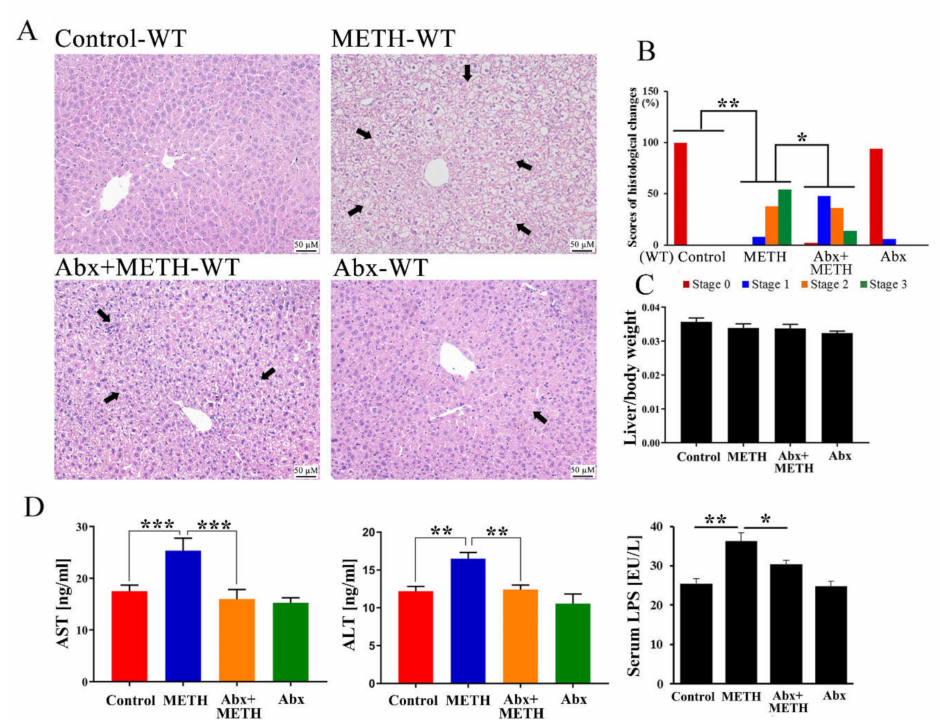
Figure 1. Histopathological changes, relative liver weight, and serum levels of AST, ALT and LPS. ( A ) H&E staining revealed shrinkage of the nuclei, loose cytoplasm and extensive vacuolar degeneration of hepatocytes (arrows) following METH treatment. However, pretreatment with antibiotics alleviated these histopathological changes. Bar = 50 µ M. ( B ) The scores of histological changes. ( C ) The relative liver weight following METH treatment. There was no significant change among groups. ( D ) The effect of METH treatment on serum AST, ALT, and LPS levels. METH treatment increased the serum AST, ALT, and LPS levels. However, treatment with antibiotics reversed this phenomenon. Abx, antibiotics. * p < 0.05, ** p < 0.01, *** p <